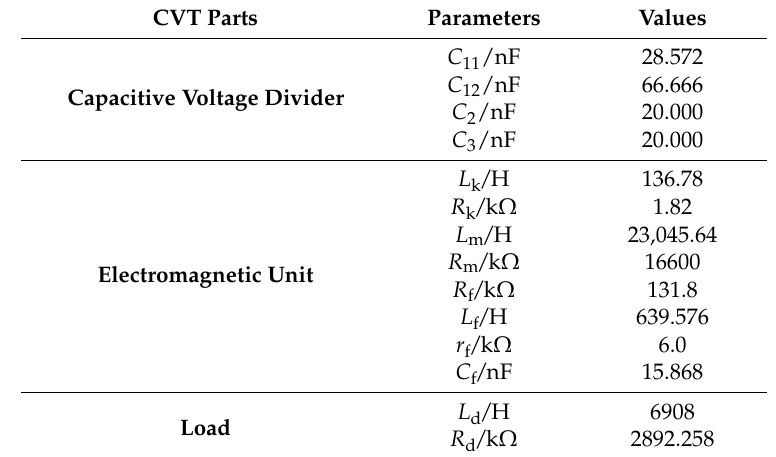
Figure 8. Simulation model of CVT. Table 1. CVT simulation parameters [6].